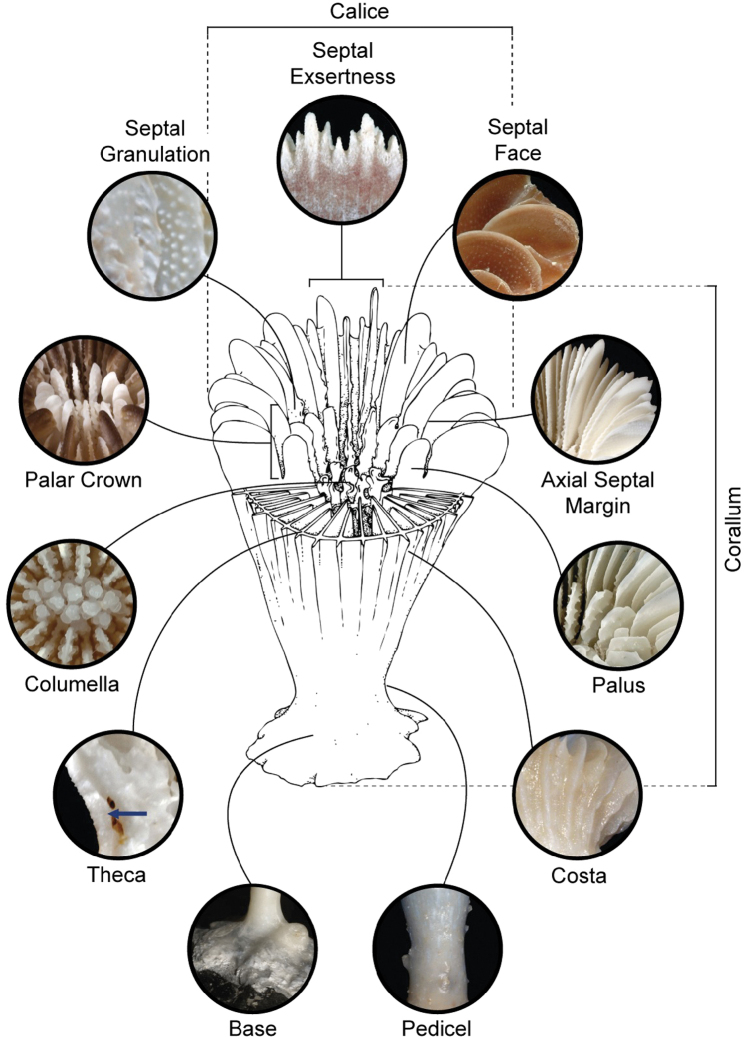
Cutaway diagram of a species of Caryophyllia illustrating the basic morphological features of an attached, solitary scleractinian (Modified from Cairns 1994). Small circular photos are from different scleractinian species and are intended to illustrate basic morphological characters used in the taxonomy of the group.